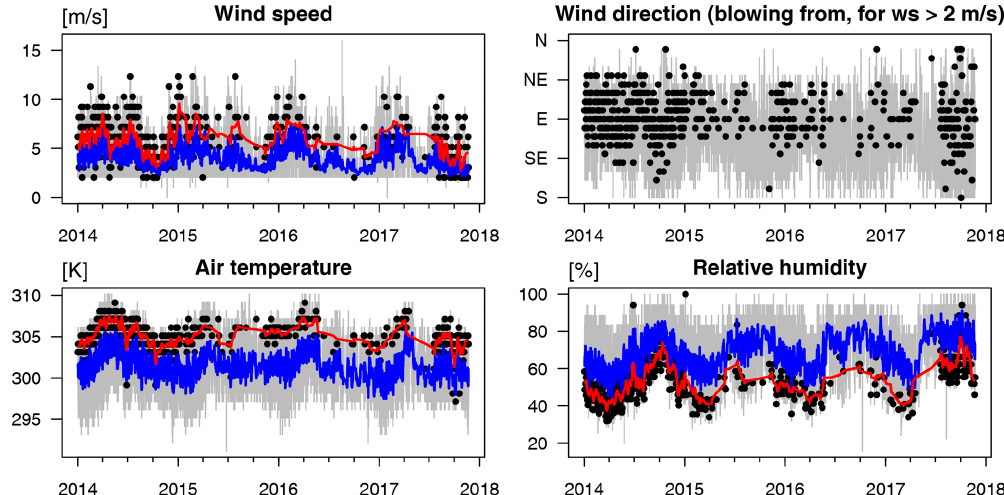
Figure A1. Meteorological conditions measured by a ground-based station at Managua airport (15km north of Masaya volcano). The data were provided by Iowa State University (https://mesonet.agron.iastate.edu, last access: 9 June 2021). Grey lines : hourly data. Blue lines : sliding average over the hourly data ( ± 2-week window). Black dots : noon-time (18:00UTC) data. Red lines : same sliding average but over the around-noon